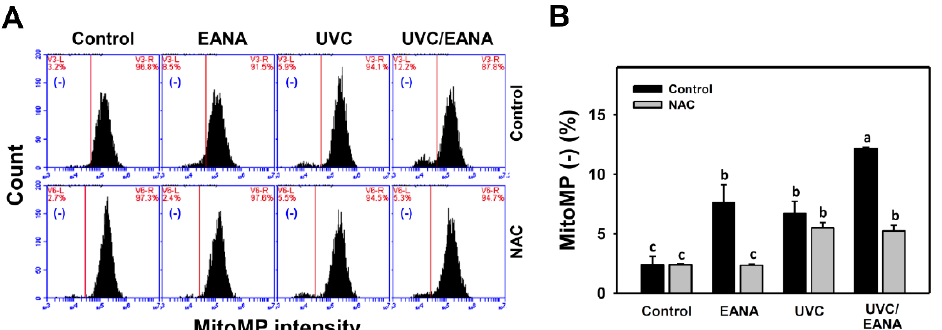
Figure 6. Mitochondrial membrane potential (MitoMP) analyses of EANA and/or UV treatments for human oral cancer Ca9-22 cells. With or without NAC (10 mM) pretreatment for 1 h, cells were post-treated with control (DMSO only), EANA (5 µg/mL), UVC (12 J/m 2 ), and combined treatment (UVC/EANA) for 24 h. ( A ) Typical flow cytometry patterns for MitoMP content. MitoMP intensity-negative regions were marked as (−). ( B ) Statistical analysis for Figure 6A. Treatments showing no overlapped labels (a–c) differ significantly between multiple comparisons ( p < 0.01–0.0001). Data, mean ± SD ( n = 3).